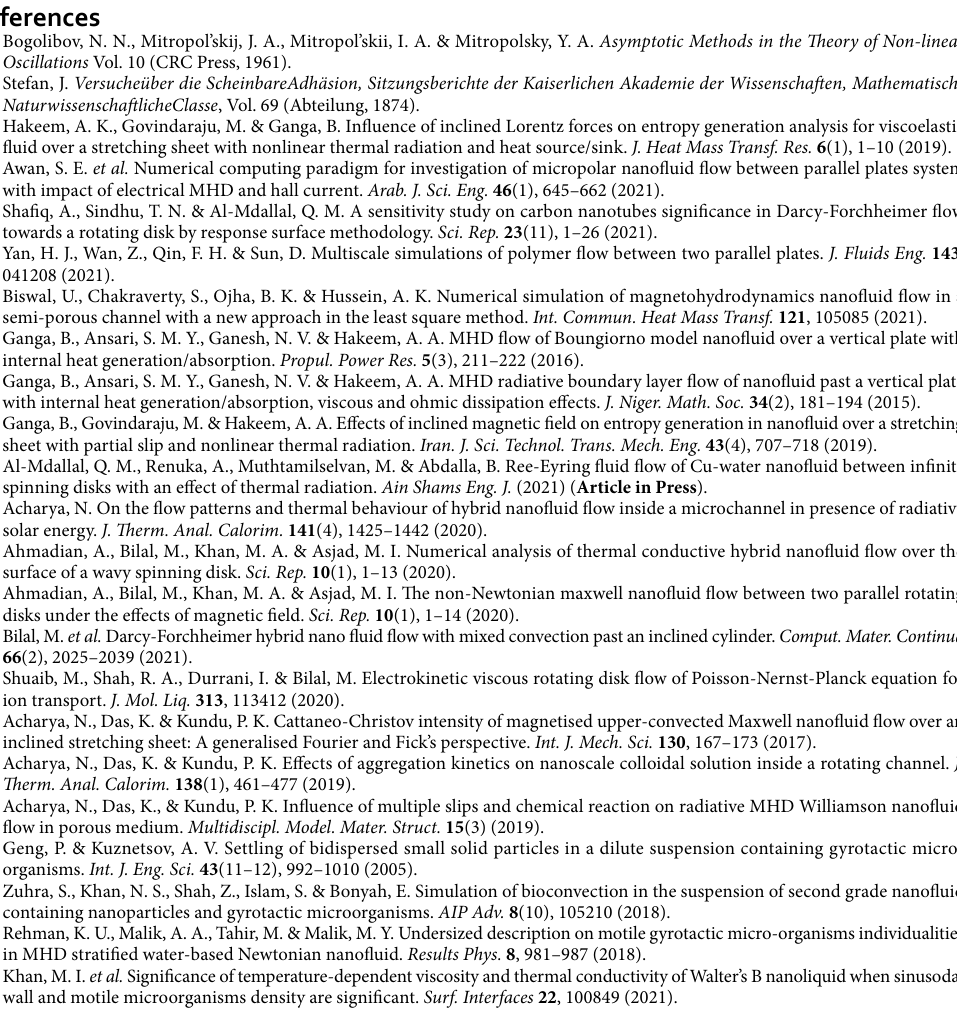
Table 2. Skin friction C f Re